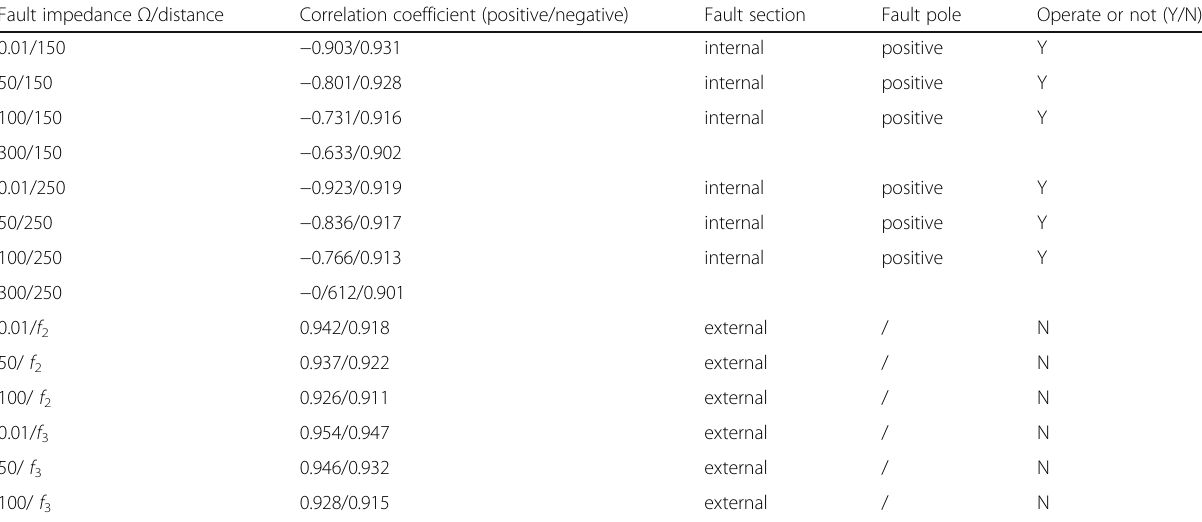
Table 3 Protection results under grounding fault with fault impedance Fault impedance Ω /distance